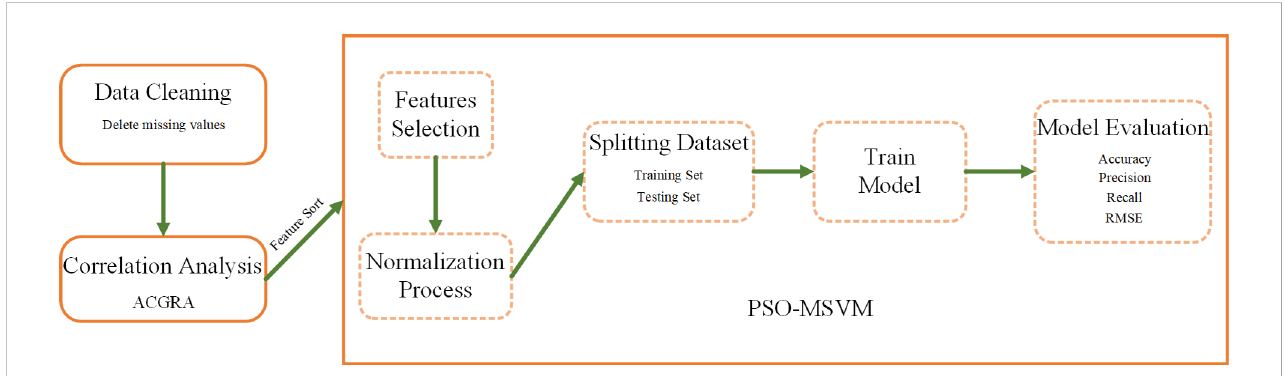
FIGURE 3 Flowchart of the river water quality assessment method based on ACGRA and